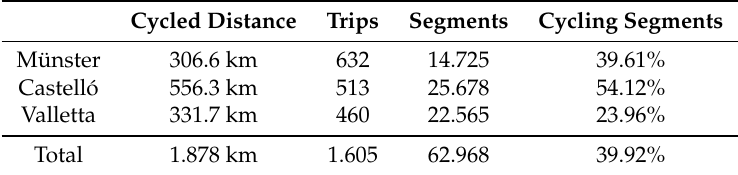
Table 3. Distribution of bicycle trips and segments recorded during the